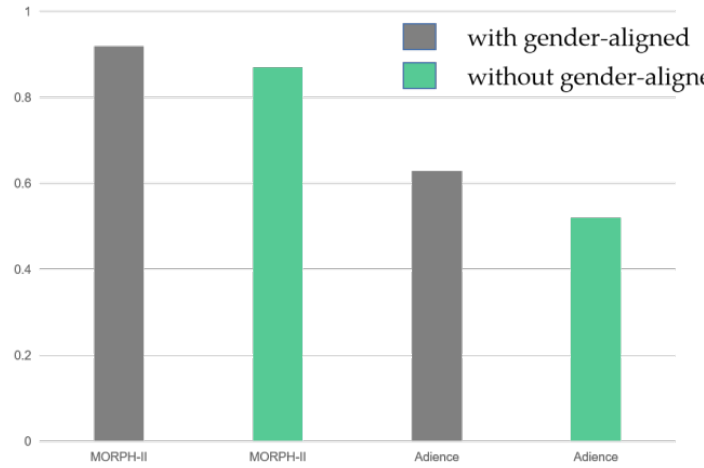
Figure 7. Age grouping with and without gender-aligned conditional probability.